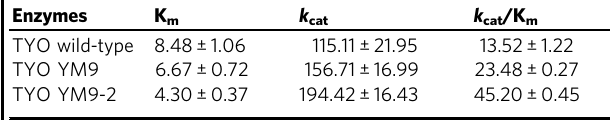
Table 2 Kinetic parameters of wild-type and mutant TYOs.